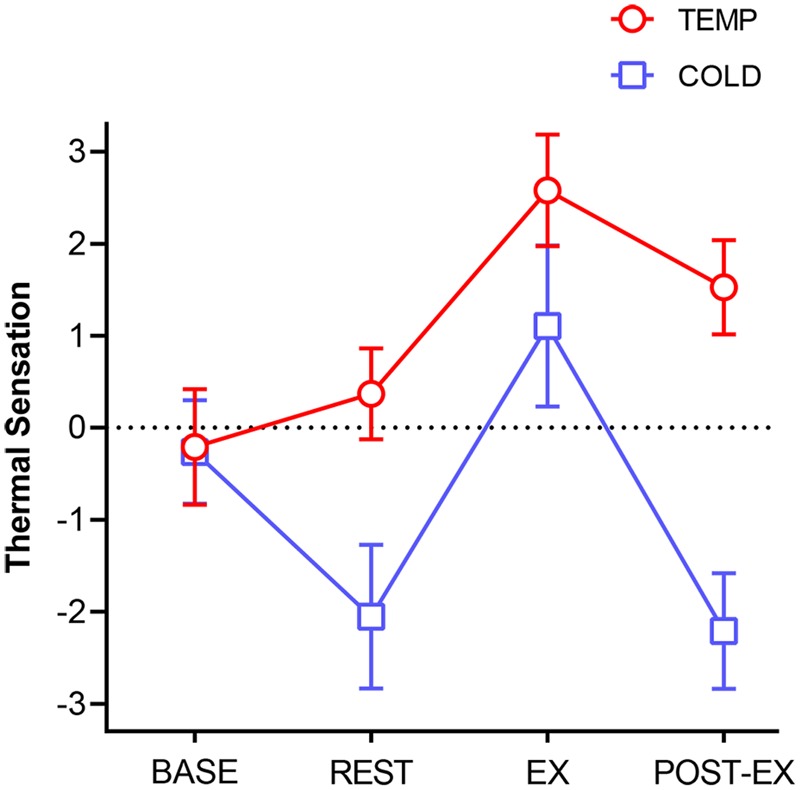
Thermal sensation for both environmental conditions. Error bars represent SD.